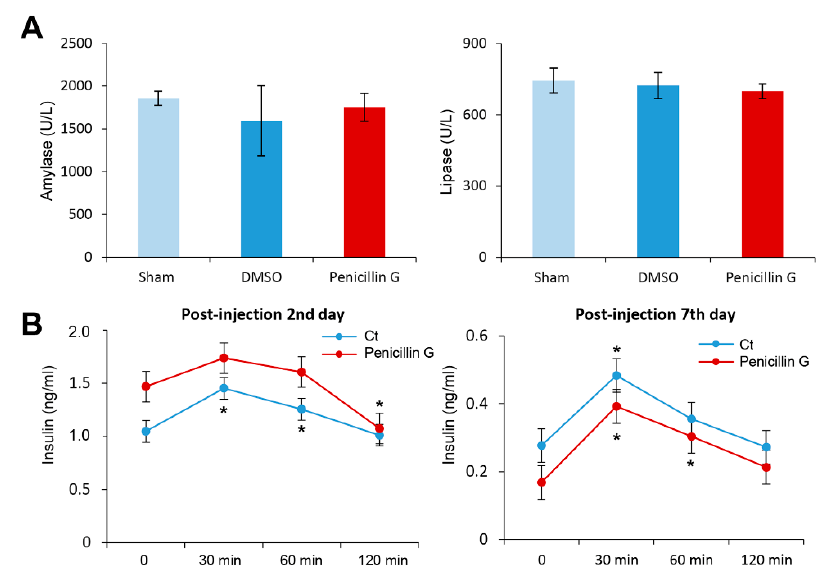
Figure 4. The effects of intrapancreatic penicillin G injection on pancreatic function. ( A ) Serum levels of amylase and lipase after intrapancreatic penicillin G injection. Injecting penicillin G into the pancreas did not significantly alter the serum levels of amylase or lipase. ( B ) Serial measurement of serum levels of insulin at certain time intervals by enzyme-linked immunosorbent assay (ELISA) after glucose infusion on the second and seventh day of penicillin G injection. Penicillin G-injected mice had slightly less insulin secretion than the control group although it was not statistically significant. Values are presented as mean ± standard deviation of three independent experiments. * p < 0.05. Abbreviation: DMSO, dimethyl sulfoxide.